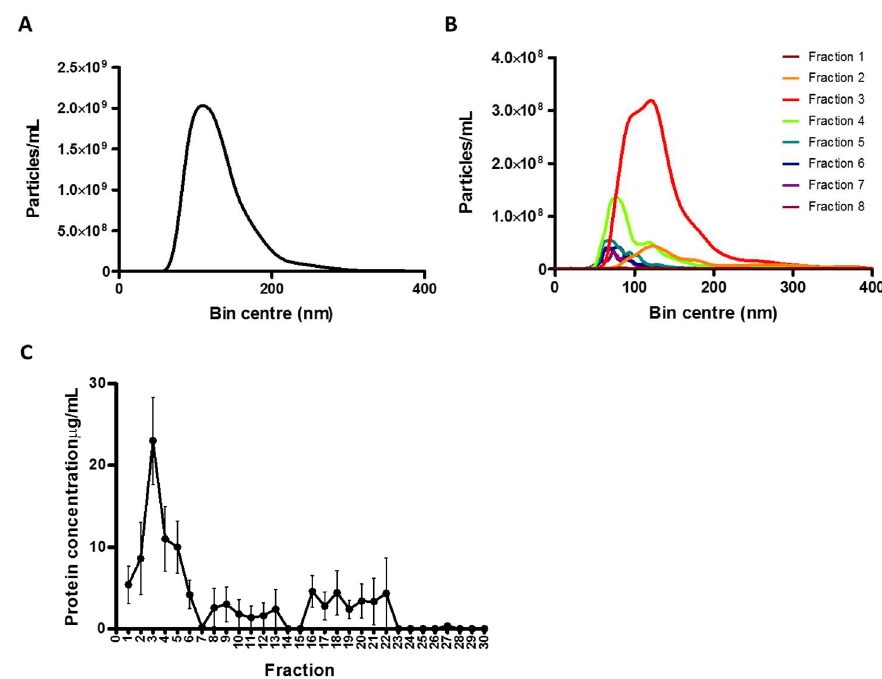
Figure 1. Nanoparticle tracking analysis and protein concentration measurement in initial ultracentrifugation sample and fractions from size exclusion chromatography (Step 1 and 2). Particle samples obtained following step 1 and 2 of the 3 method-combination protocol were processed to nanoparticle analysis (NTA) and protein concentration measurement. ( A ) NTA of the initial ultracentrifugation (UC) sample. Sample was diluted (1/50) in filtered sterile phosphate buffer solution (PBS) and measured using a Nanosight NS300. ( B ) NTA of the fractions from size exclusion chromatography (SEC). The initial UC sample was processed through SEC and fractions were measured by NTA. Fractions were diluted (1/20) in filtered PBS and measured using a Nanosight NS300. ( C ) Protein concentration measurement in the SEC fractions. Protein concentration was measured using a Nanodrop 200. The mean ± SEM of n = 5 independent experiments is shown.